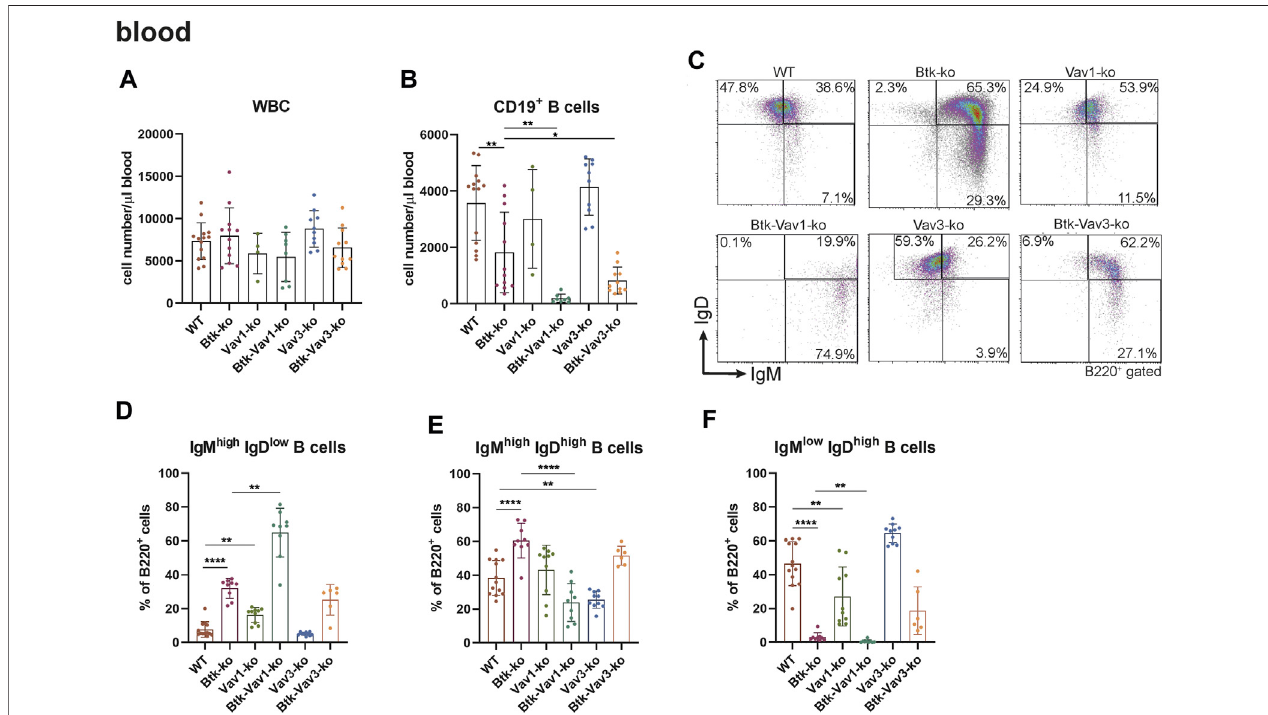
FIGURE 2 | Btk/Vav double de fi ciency causes reduced B cell numbers in the blood. (A) Numbers of total WBCs measured with an Animal Blood Counter are shown. Statistical analyses of fl ow cytometry representing total CD19 + B cells (B) , representative fl ow cytometry plots of IgM/IgD B cell subpopulations in the blood for each genotype (C) , statistical analyses of fl ow cytometry representing IgM high IgD low (D) , IgM high IgD high (E) and IgM low IgD high (F) B cell percentages in the blood are shown.Eachpointrepresentsdatafromasinglemouse.Datainthegraphsareshownasmeans±SD( n =atleast4micepergroup).Dataaremergedfromatleast three independent experiments. * p < 0.05, and ** p < 0.01. p -values were determined using a two-tailed Student ’ s t test or Mann-Whitney-U test. WT, Vav1-, Vav3-and Btk/Vav3-knockouts were analyzed in an age range from 7 – 15 and Btk- and Btk/Vav3-knockouts from 8 – 29 weeks (3 mice each were analyzed in the age range from 26 – 29 weeks, remaining animals were 8 – 14 weeks old). Gating strategy is shown in Supplementary Figure S5